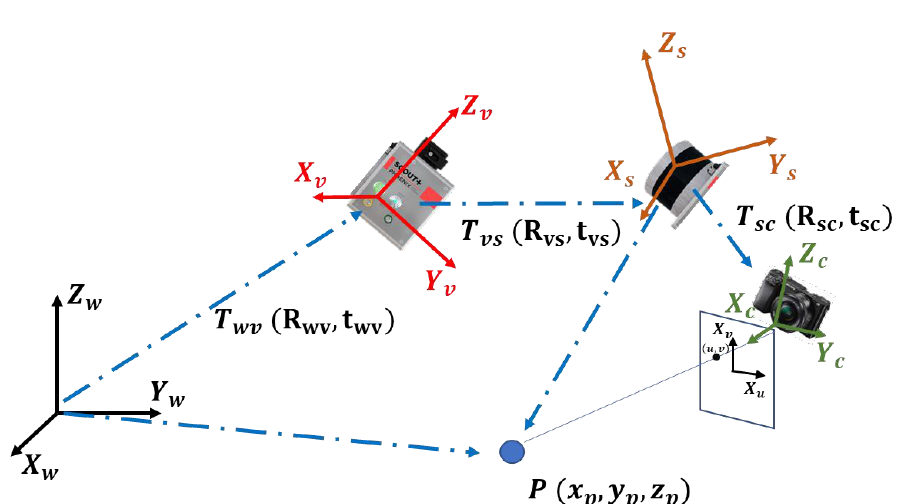
Figure 6. Camera-LiDAR calibration: Coordinate systems for spatial synchronization.